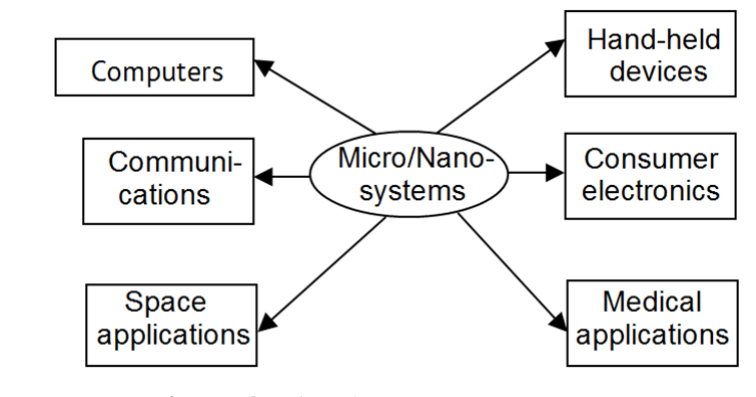
Figure 4. Micro/nanosystem